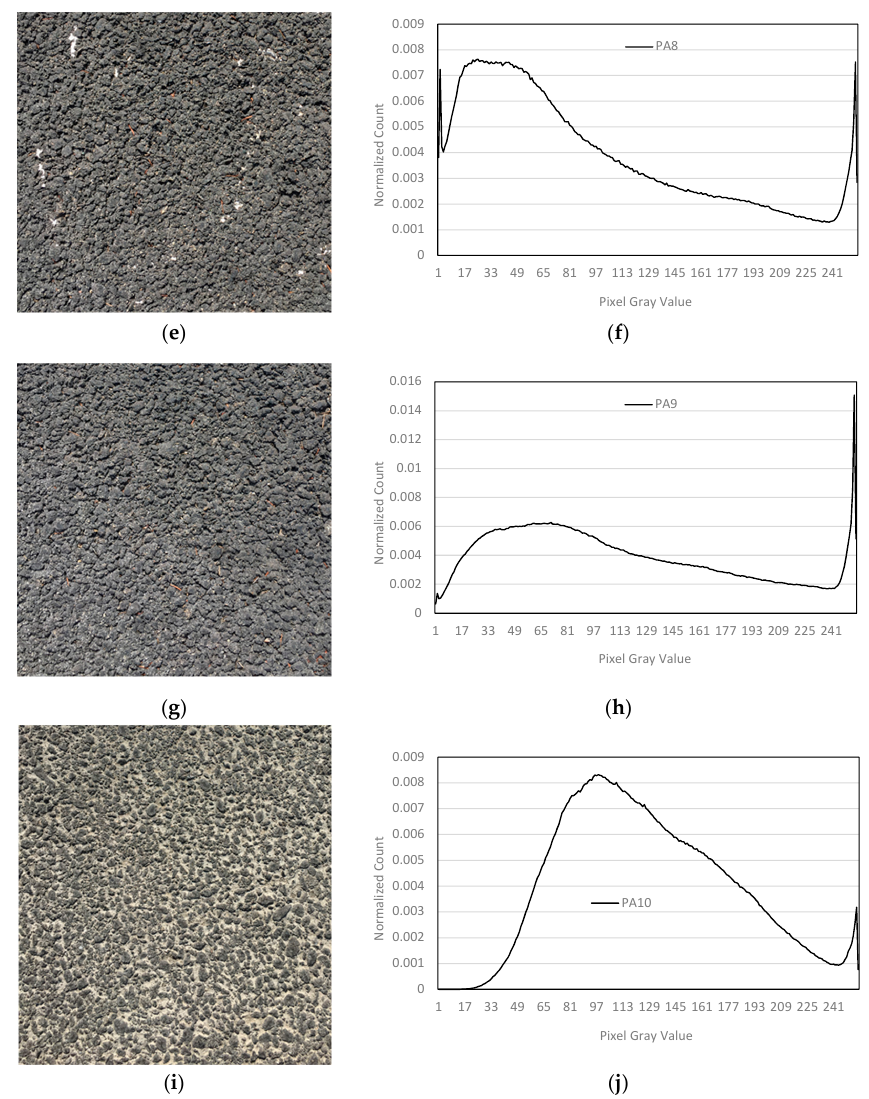
Figure A1. Images acquired with a cell phone camera on the porous asphalt site and corresponding gray level image histogram for: location 6 in ( a , b ), respectively; location 7 in ( c , d ), respectively; location 8 in ( e , f ), respectively; location 9 in ( g , h ), respectively; and on location 10 in ( i , j ), respectively.